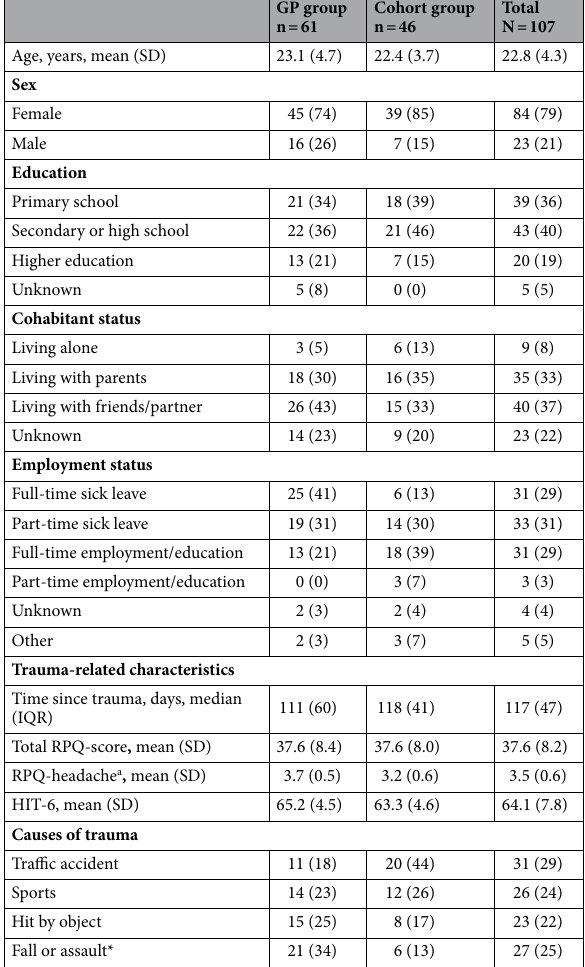
Table 1. Demographic data and trauma-related characteristics. Numbers in cells are n (%) unless otherwise specified. *A total of 4 individuals reported assault. a The range of RPQ-headache was 2–4 in both the groups. The percentages do not always add up to 100% due to rounding. GP general practitioner, HIT headache impact test [range 36–78 (worst)], IQR interquartile range, RPQ Rivermead Post-Concussion Symptoms Questionnaire [range 0–64 (worst)], SD standard deviation.